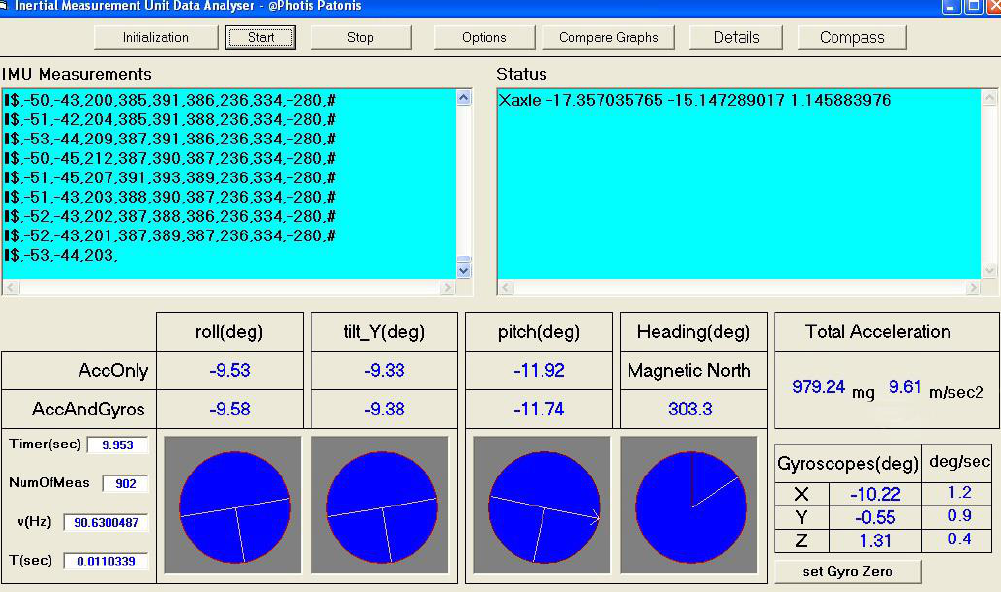
Figure 7. Roll angle estimation by raw outputs and the fusion method in static condition.